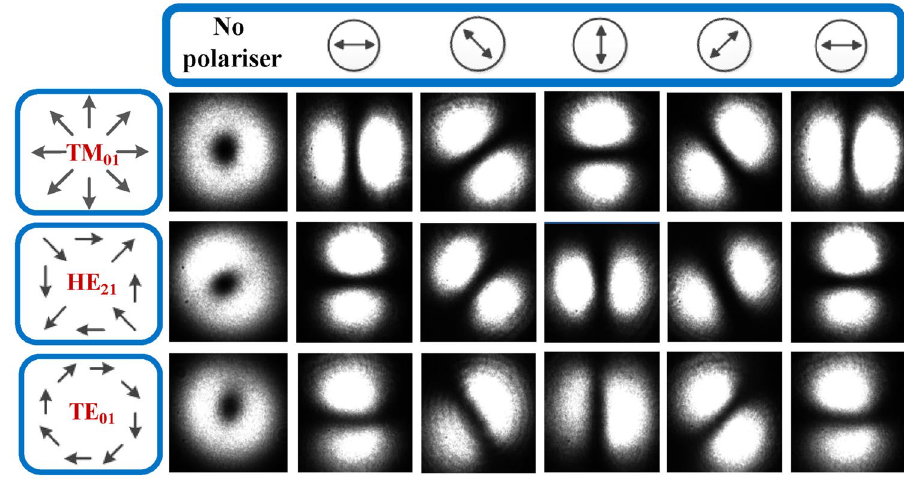
Figure 2. Identification of the TM 01 , HE 21 and TE 01 vector modes via a linear polariser.